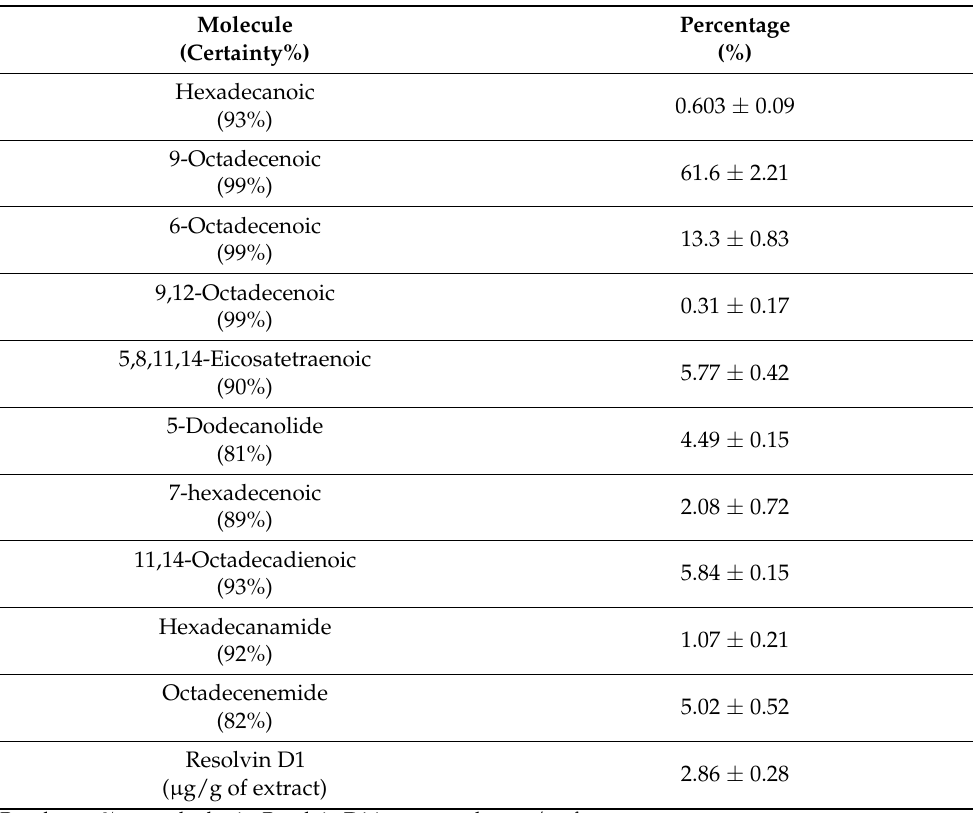
Table 2. Pig lard hydro alcoholic extract